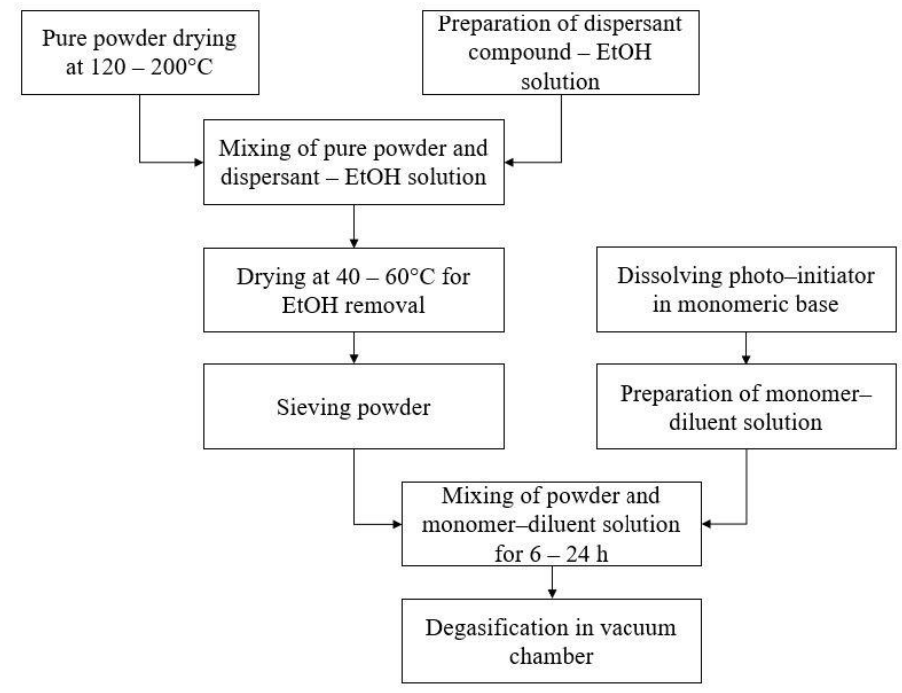
Figure 4. Flow-chart of general ceramic suspension production process.